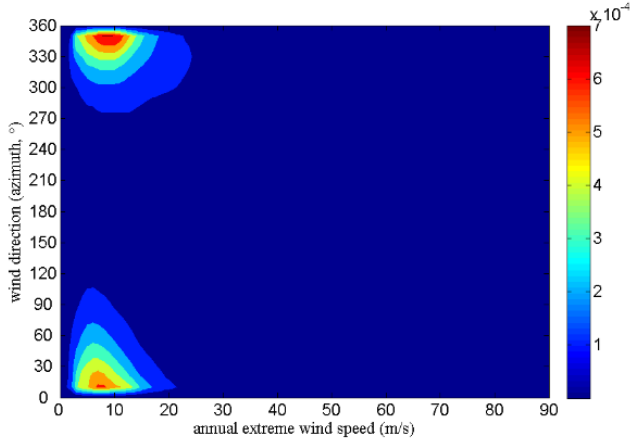
Figure 13. Joint probability model of the annual extreme wind speed of typhoons and the wind direction. Then, we obtain the annual probability of failure of each suspension tower in the normal segment of the transmission line using Equation (25), and the failure probabilities of tension towers and terminate towers are taken to be zero. Clustering the suspension towers based on the line direction and span, we obtain three clusters of the towers, with their centers corresponding to different line directions (Figure 14a). In Figure 14a, n denotes the number of the towers located in the corresponding cluster. Figure 14b further shows the failure class of each tower in three clusters. The failure class is defined by the annual probability of failure calculated from the Equation (25) and five classes are classified according to the calculation result. In Figure 14a,b, the red cluster accounts for the majority of the towers and their failure probabilities scatter in the five classes. Considering the blue cluster and the black cluster, we find that most of the towers have larger failure probabilities. Defining one strain section of a line as starting from one tension tower and ending with the adjacent tension/terminate tower, there are 14 strain sections in the normal segment of the transmission line. To evaluate each strain section, Figure 15a,b first give the basic information (including the length and the number of the towers) of each strain section, and we have the essential cognition that the longer the strain section is, the more towers are included in the section. Figure 15c,d further show the statistical result of the annual failure probability of the towers in each strain